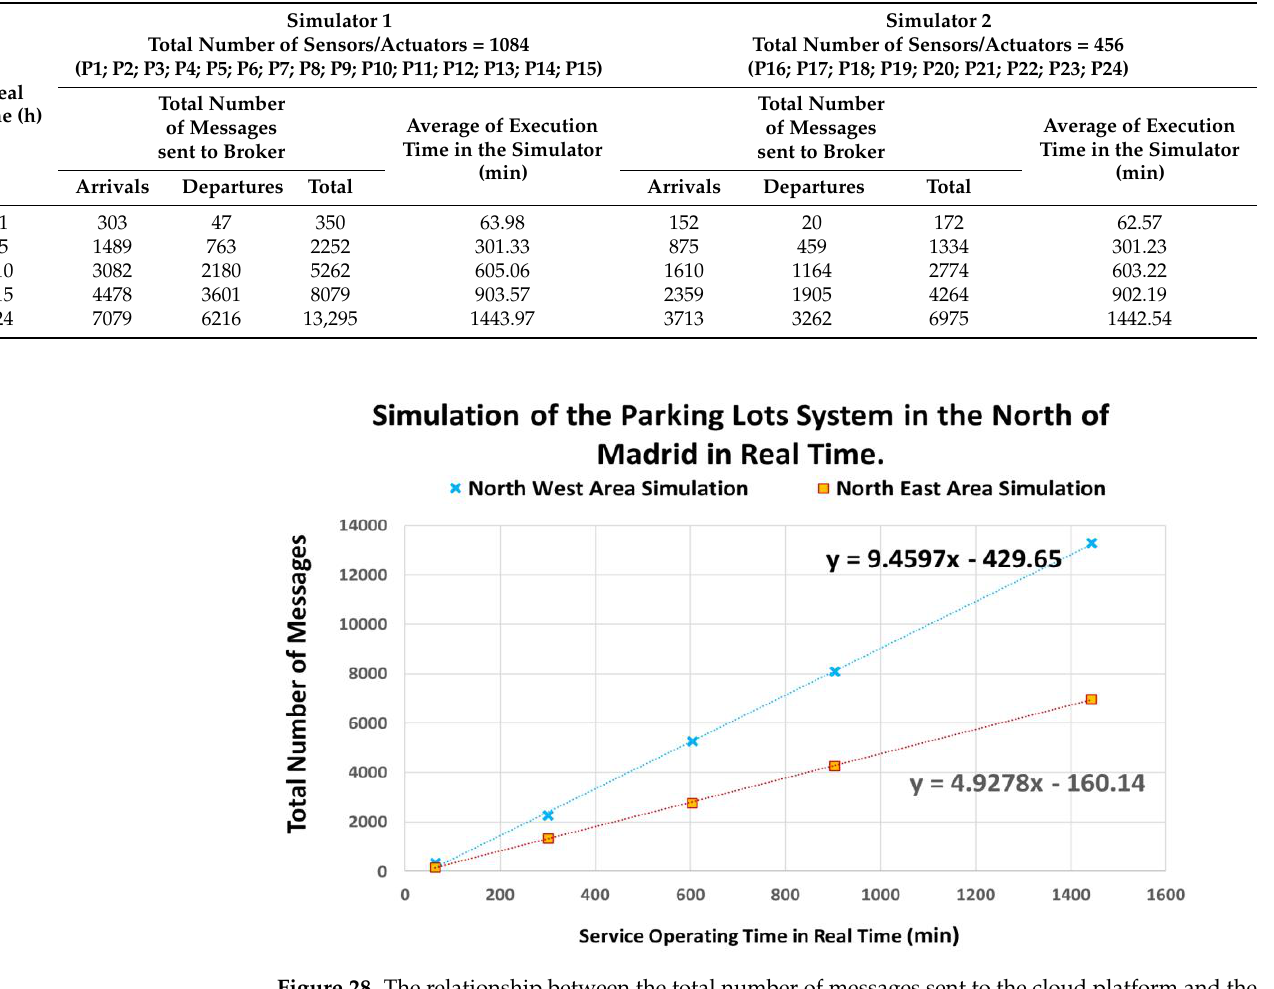
Table 15. Real-time simulation of the operation of the parking lots in the north of Madrid.